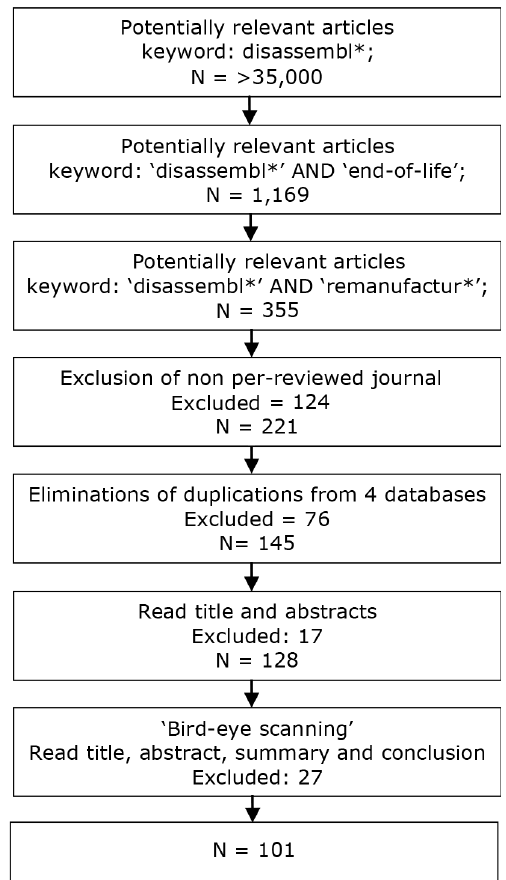
Figure 2. Procedures of literature selection